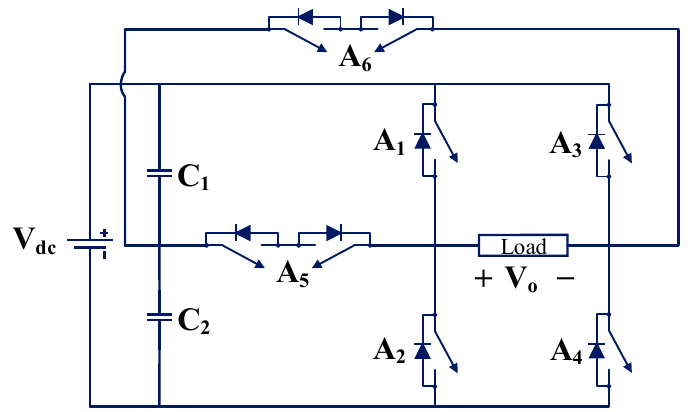
Figure 32. Single-phase five-level FT MLI (TP35) [67].